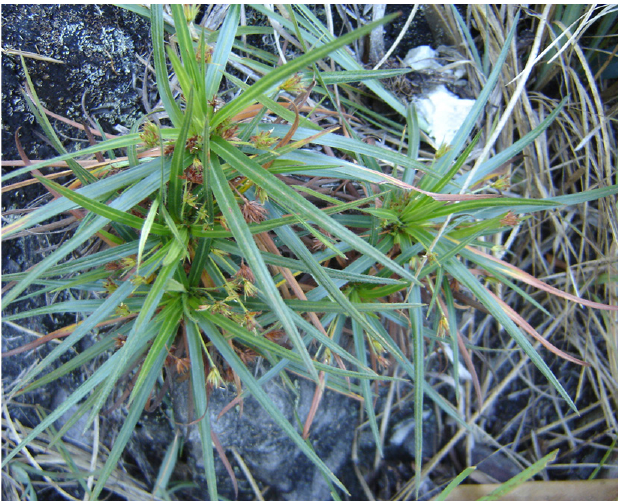
Figure 1. Cephalocarpus confertus